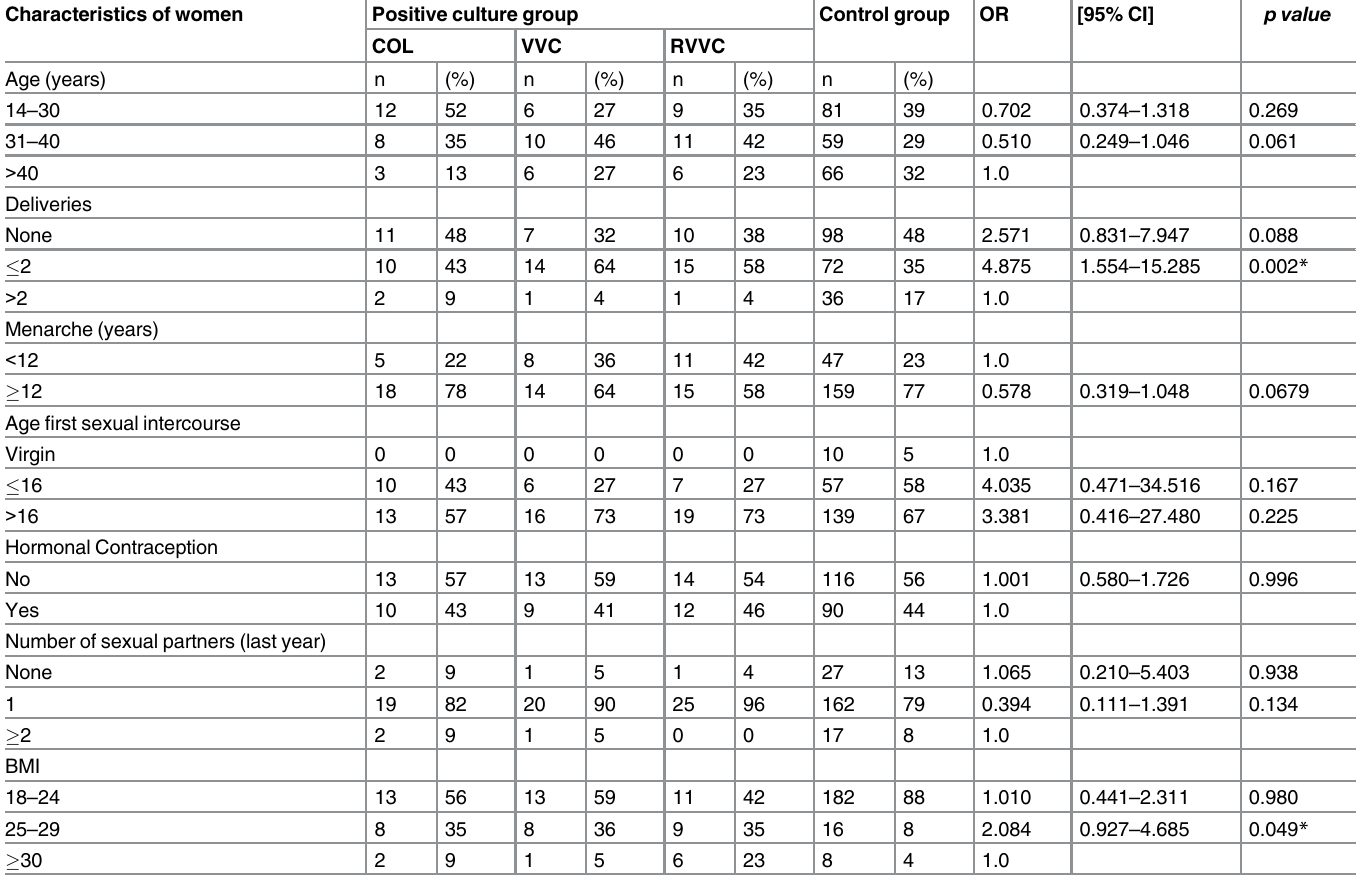
Table 1. Selected epidemiologic characteristics of 277 women who participated of study. Characteristics of women